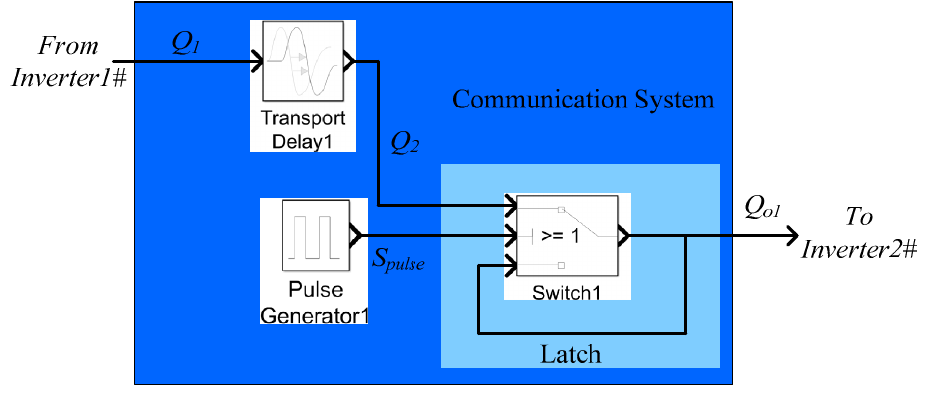
Figure 6. The simulated communication system in Matlab.